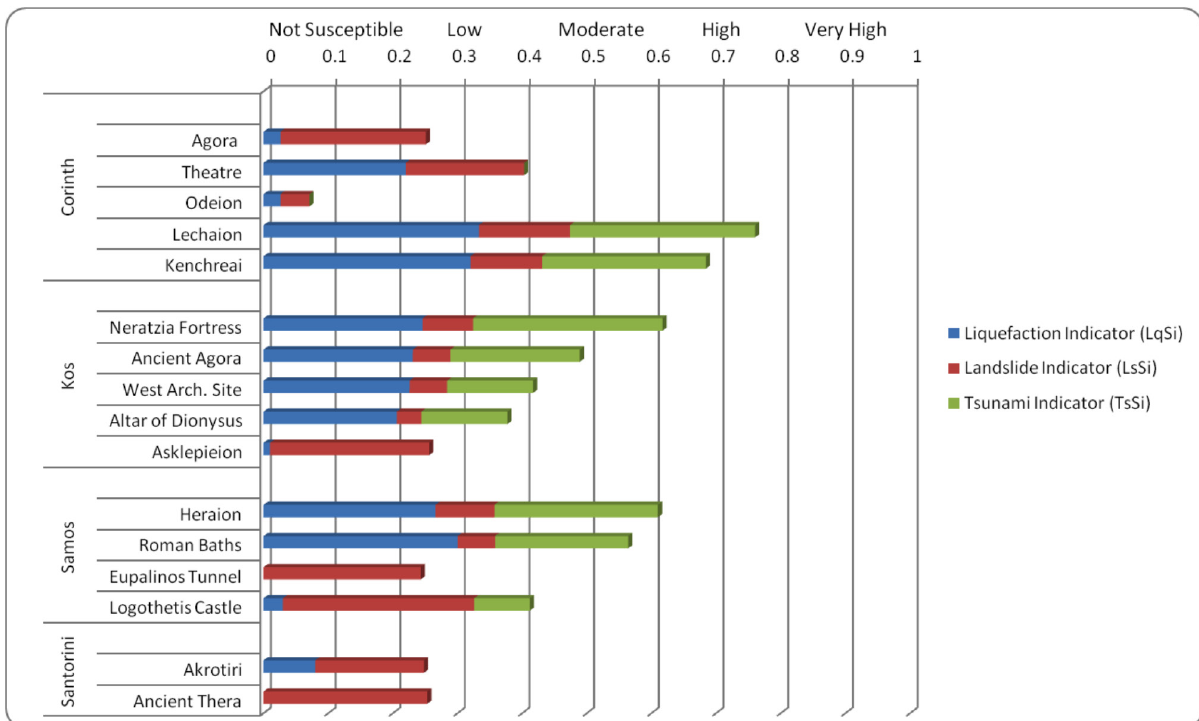
Figure 7. The Spatial Susceptibility index for the archaeological sites under study (modified after Minos-Minopoulos et al.,